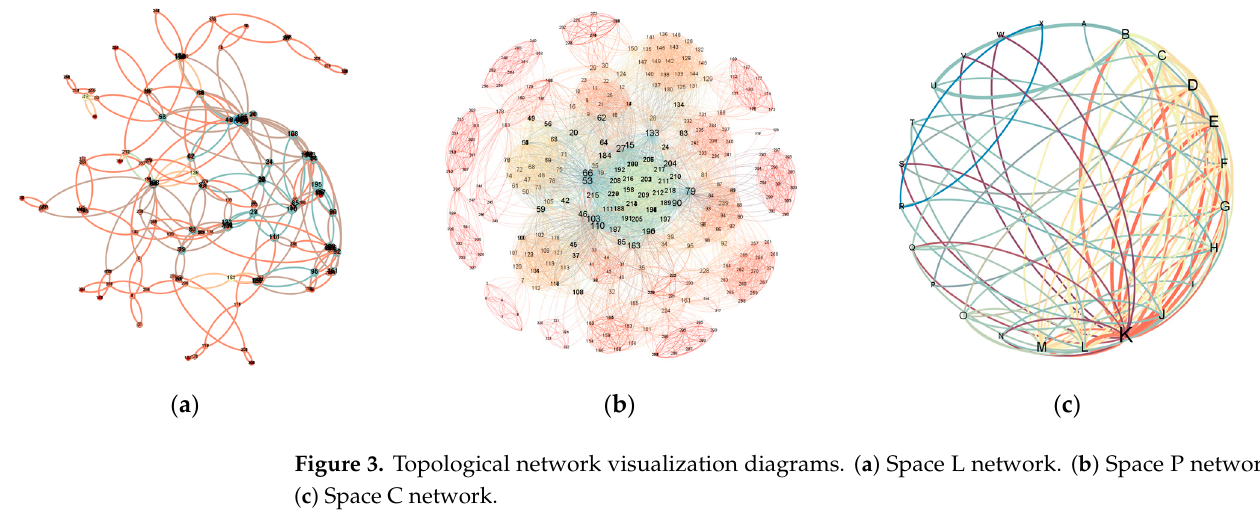
Figure 2. Beijing subway line network.